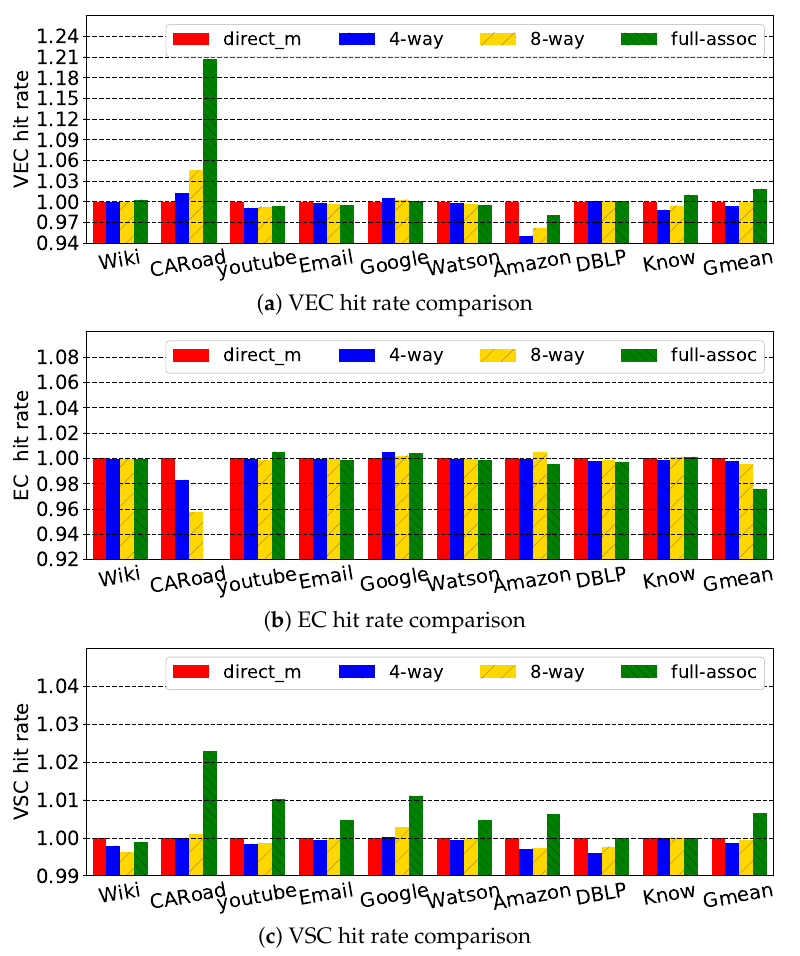
Figure 16. Comparison of the on-chip cache hit rate for different on-chip cache associativities. Table 4. Access latency of the on-chip cache configuration